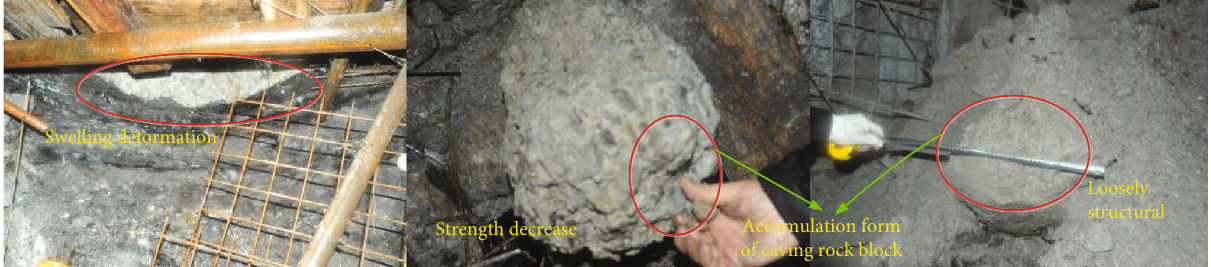
Figure 2: The morphological characteristics of falling